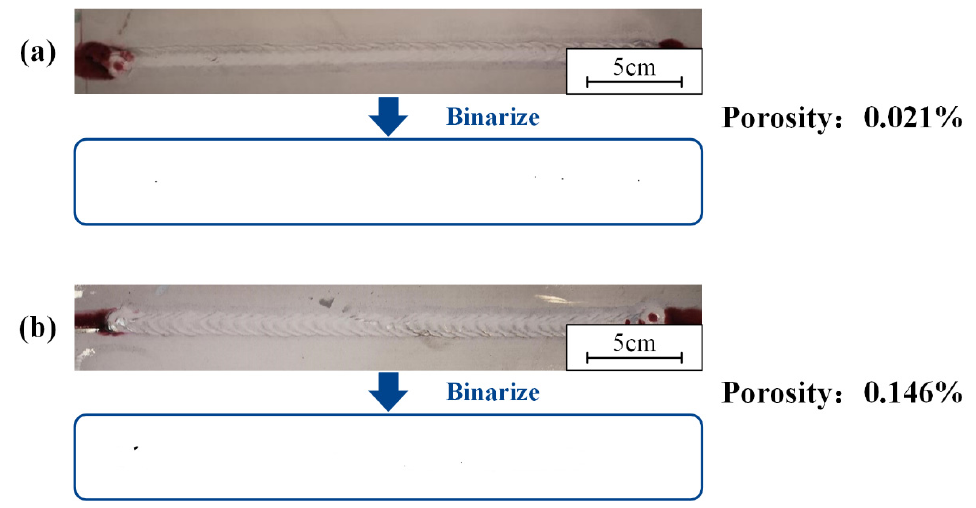
Figure 14. The result of the permeation testing and the porosity under different cleaning speeds: ( a ) 0.5 m/min; ( b ) 0.7 m/min.